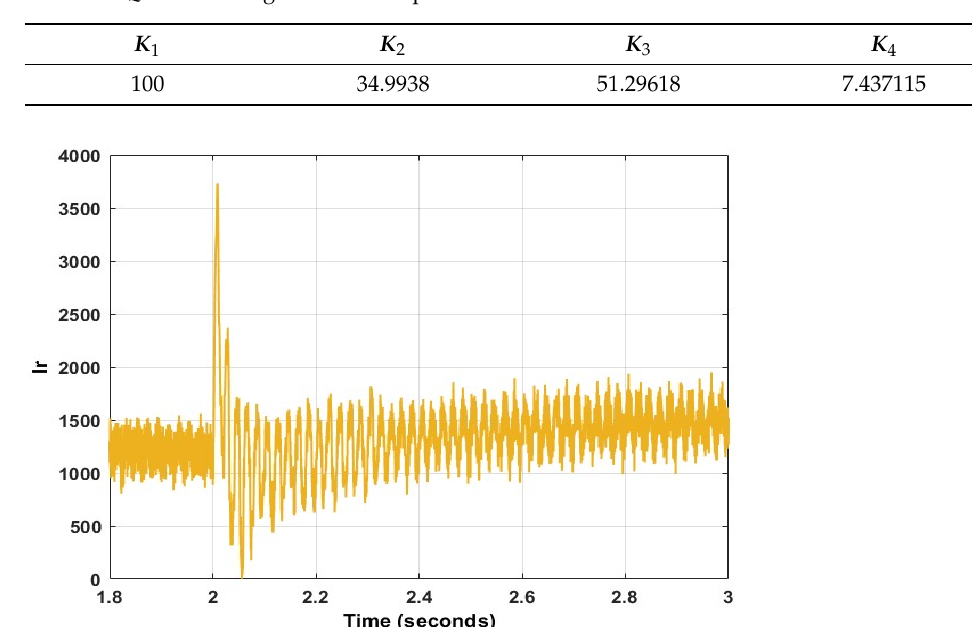
Figure 28. Rotor direct axis current average using DCI at 70% dip.